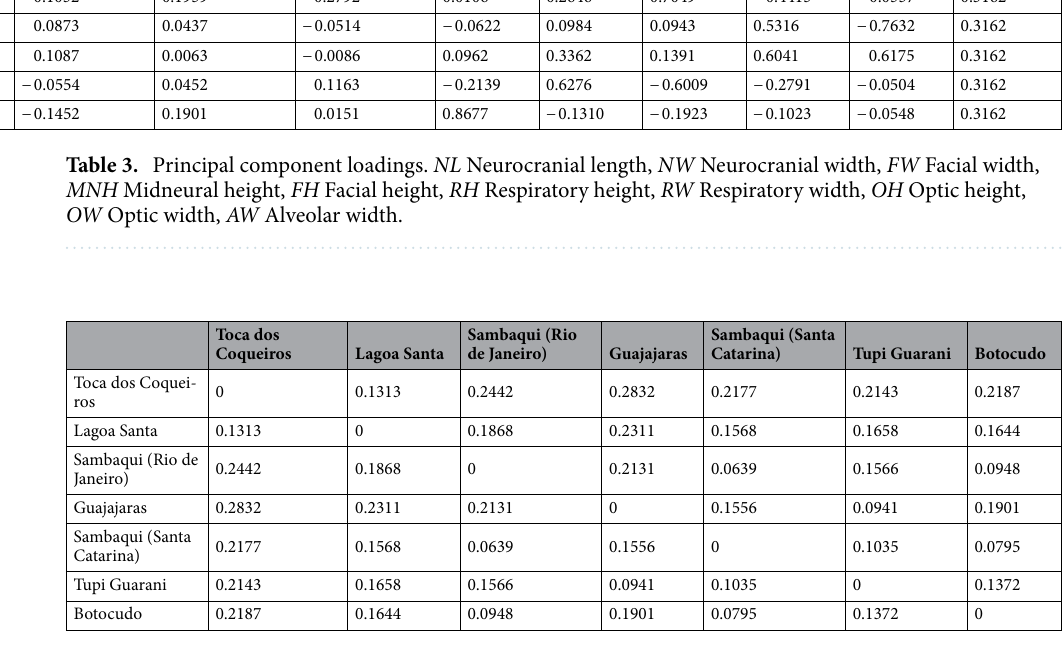
Table 4. Euclidean distances among